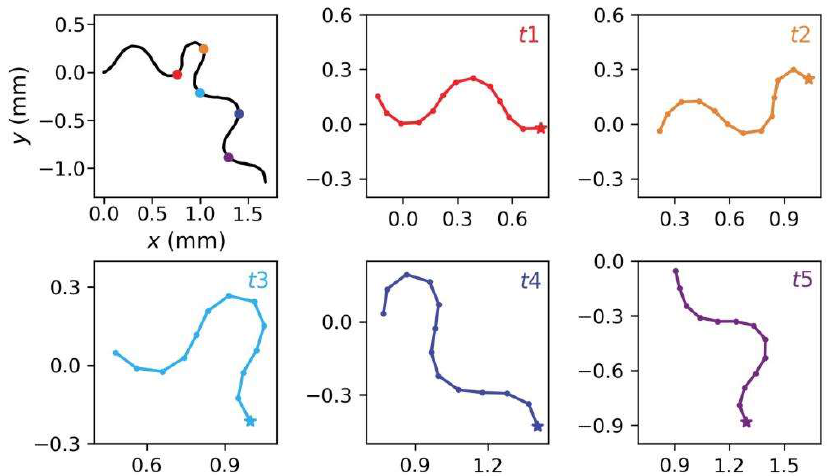
Figure 13. Shape of rigid link system during steering. The upper left diagram shows the model trajectory, and the shapes of the rigid link system at the position indicated by the five colored points are shown in the similarly colored sub-graphs. The pentagram represents the head tip (i.e., Node 1 of the system).